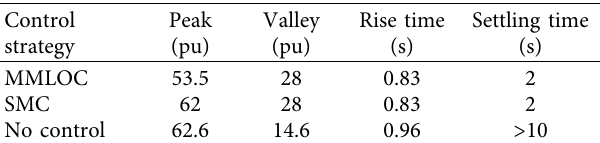
Figure 10: Te control signal of SVC in MMLOC strategy. Table 4: Te performance index rotor angle under three-phase